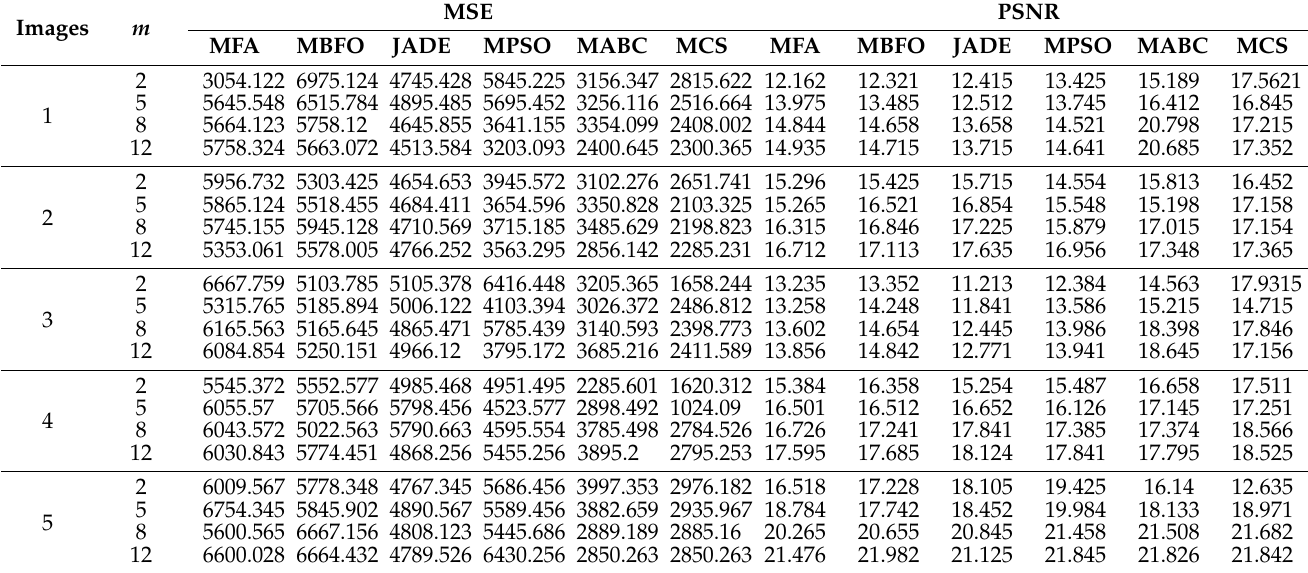
Table A4. MSE and PSNR computed using different optimization algorithms with minimum cross entropy.